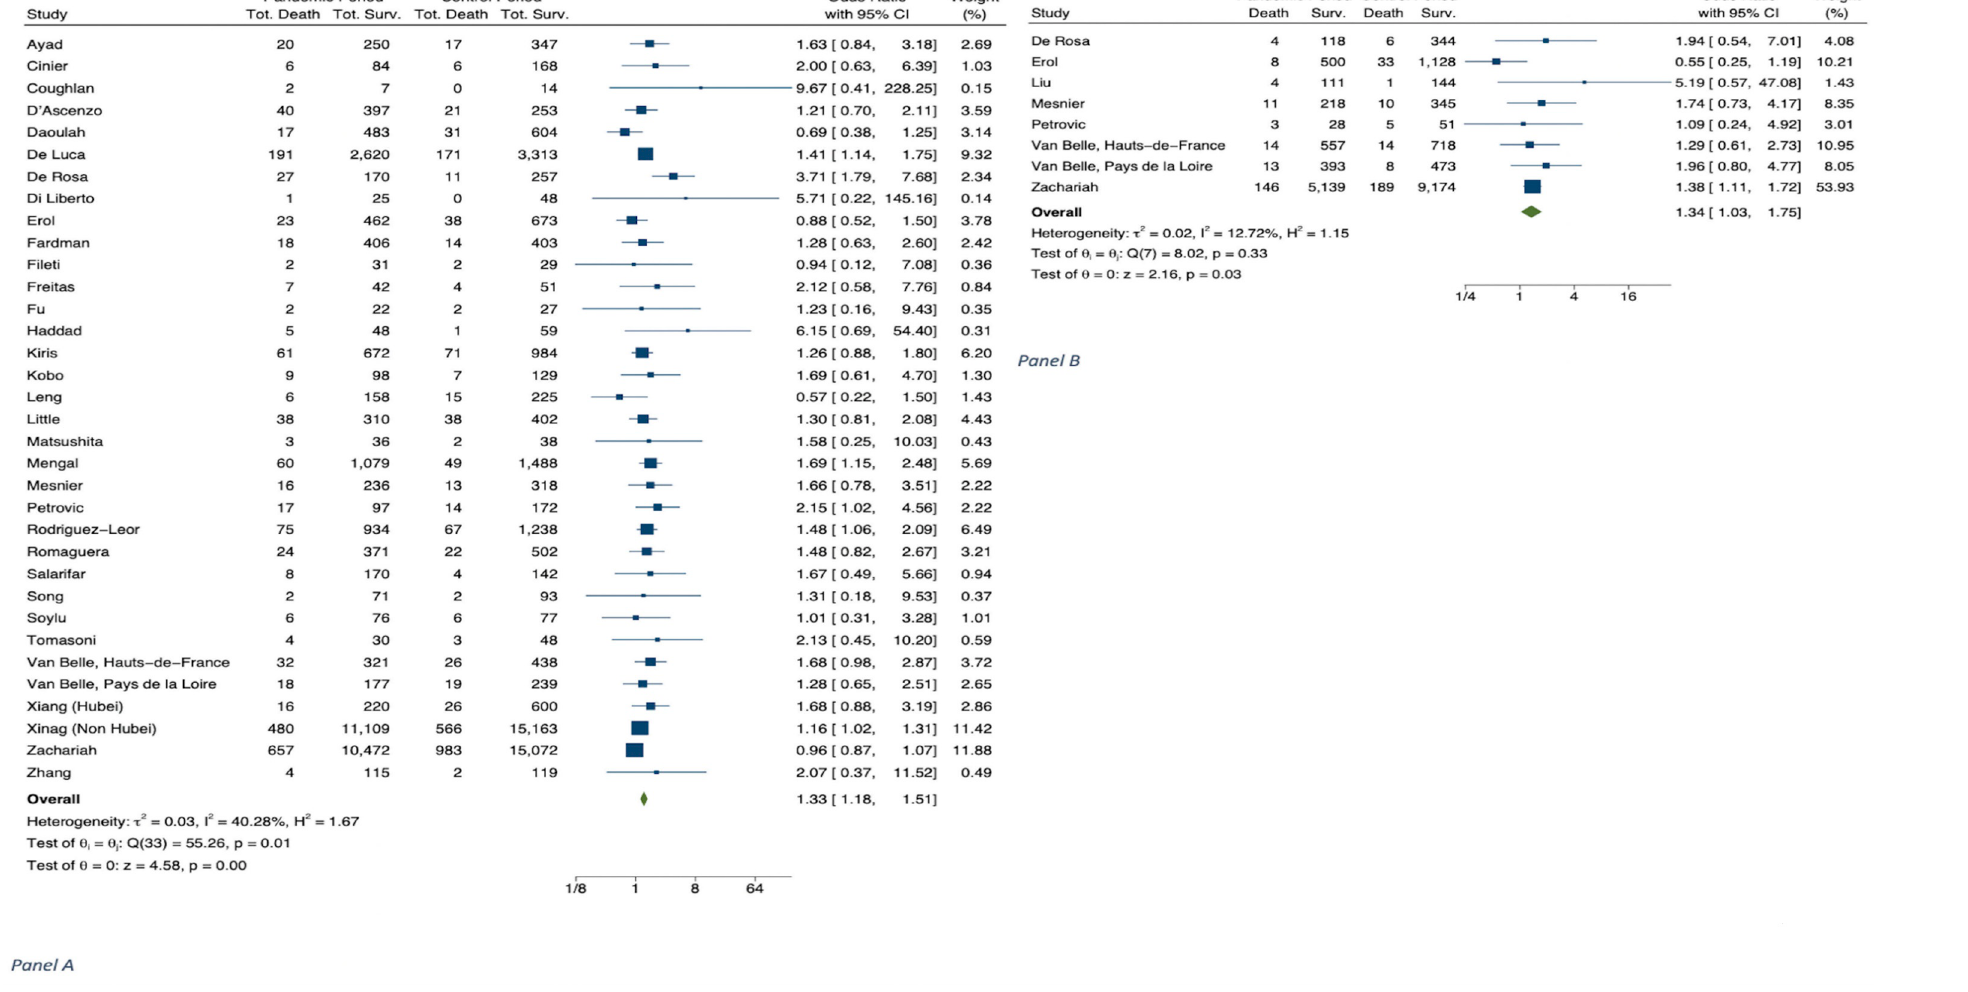
Figure 2. Panel ( A ) STEMI patients: Hospital mortality during COVID-19 pandemic in 2020 vs. corresponding control period. Panel ( B ) NSTEMI patients: Hospital mortality during COVID-19 pandemic in 2020 vs. corresponding control period.